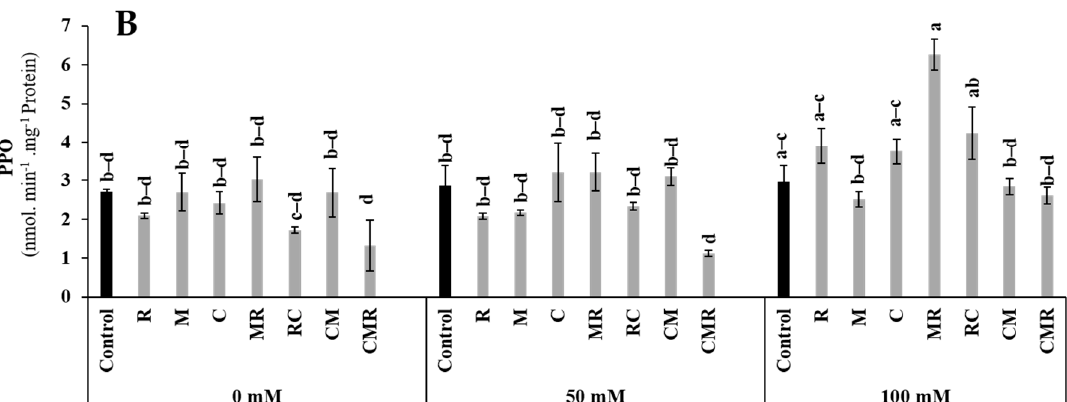
Figure 8. Impact of salt stress (0, 50, and 100 mM NaCl) on ( A ) POX and ( B ) PPO in lettuce subjected to different biostimulant treatments; control plants (non–amended, non–inoculated), and plants inoculated with plant growth promoting rhizobacteria (R) and/or arbuscular mycorrhizal fungi (M), and/or amended with composts (C). Means (±SE; 5 biological replicates) followed by the same letters are not significantly different at p < 0.05 (Tukey’s HSD).